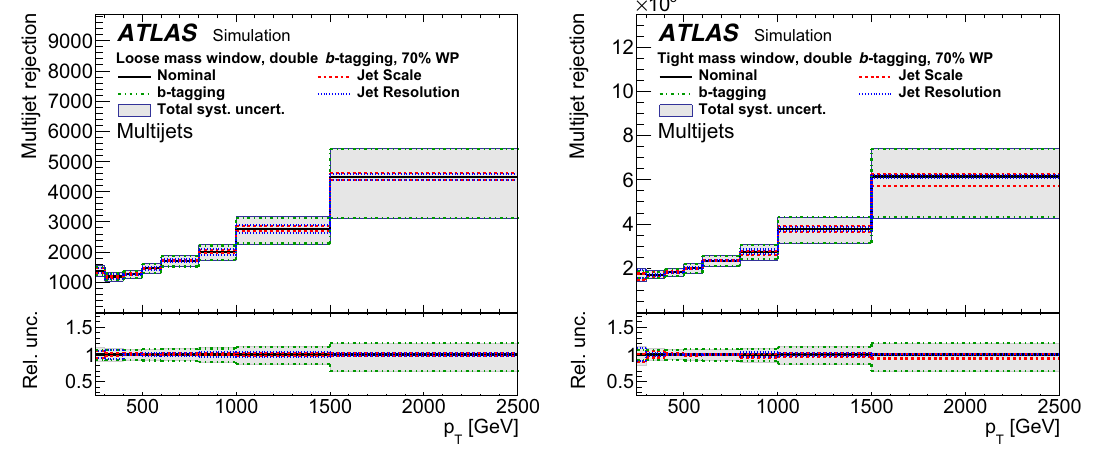
Fig. 7 Rejection of multijet background as a function of the Higgs-jet p T for the loose (left) and tight (right) mass window requirements, in combination with the 70% double- b -tagging working point. The nomi- nal curves correspond to the requirement on the MV2c10 discriminant described in Sect. 6.2. Systematic uncertainties defined in Sect. 5 as